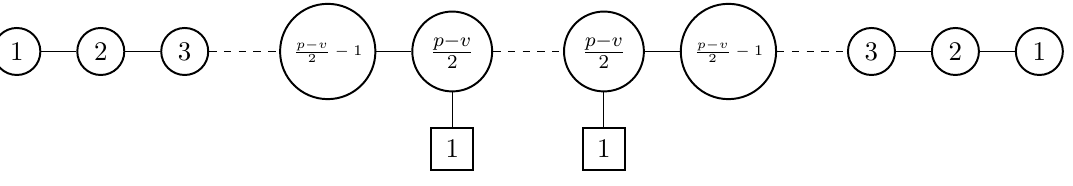
Figure 4 . The Kronheimer-Nakajima quiver associated to a ’t Hooft loop labelled by B = ( p= 2 ; (cid:0) p= 2) in the sector v = ( v= 2 ; (cid:0) v= 2) with v 6 = 0 in an N = 2 (cid:3) SU(2) theory. The gauge node U( p (cid:0) v ) is repeated v + 1 2